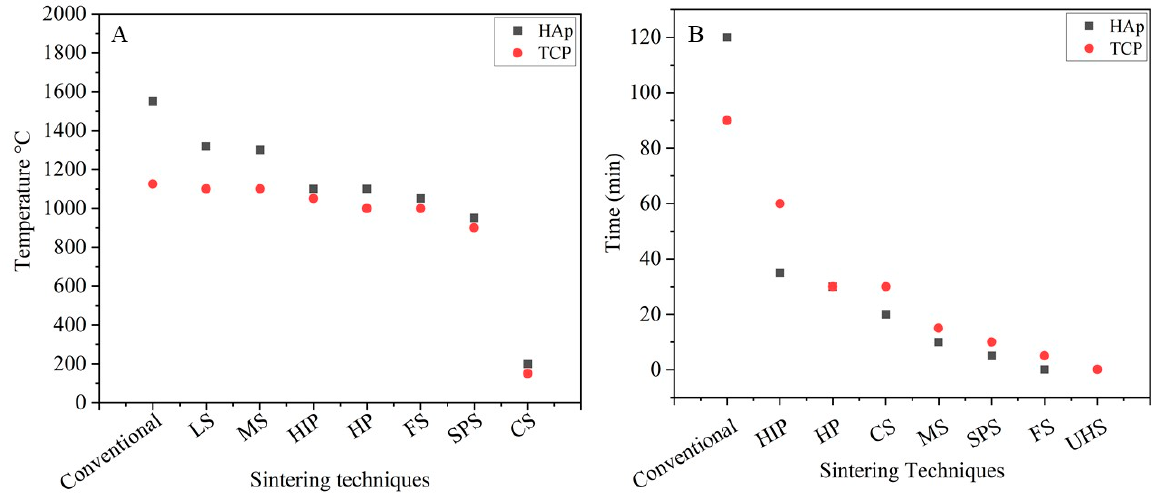
Figure 5. Comparison of sintering ( A ) temperature and ( B ) time required for conventional and advanced sintering techniques.